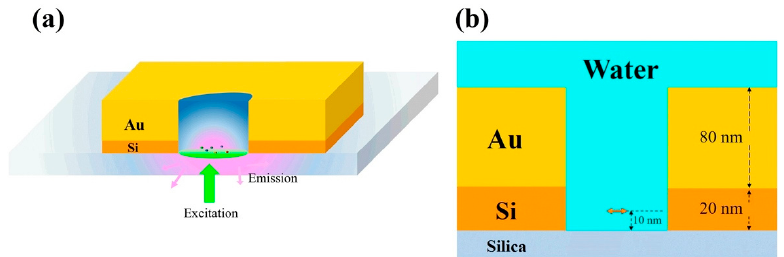
Figure 1. ( a ) Three-dimensional illustration of Au/Si hybrid nano-aperture used as antenna; ( b ) cross ‐ sectional scheme of the hybrid structure consisting of an 80 ‐ nm Au layer on the glass separated by a 20 ‐ nm Si layer. The diameter of the nano ‐ aperture is 40 nm, and the dipole is 10 nm above the glass surface. The background is water with a refractive index of 1.33.